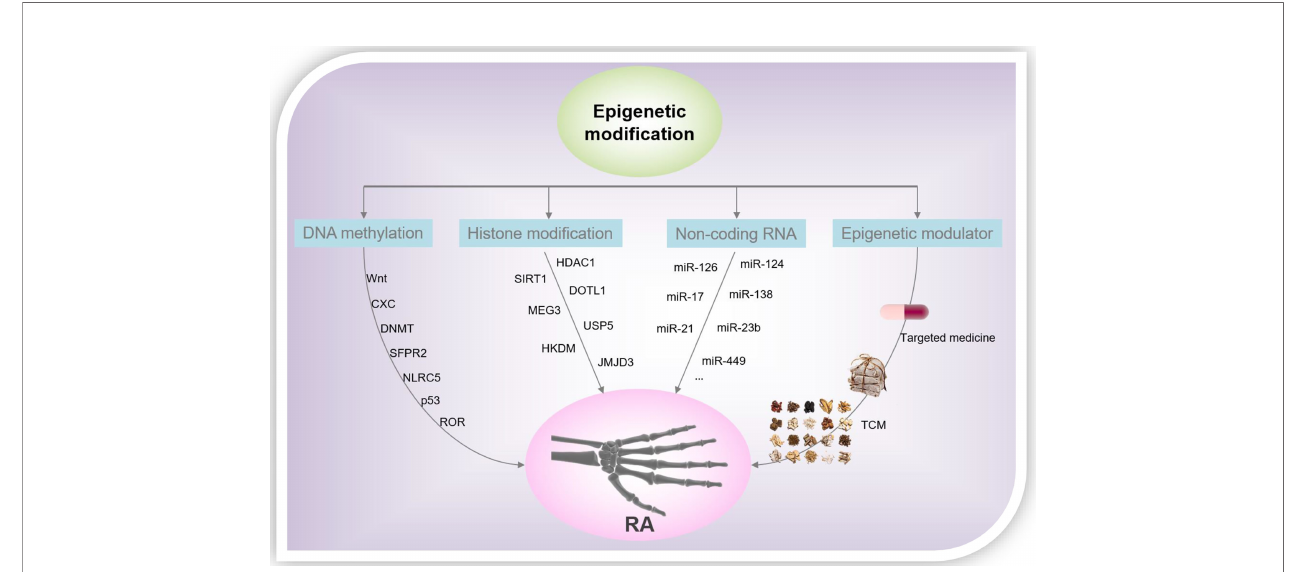
FIGURE 3 | RA-related epigenetic modi fi cation and drug